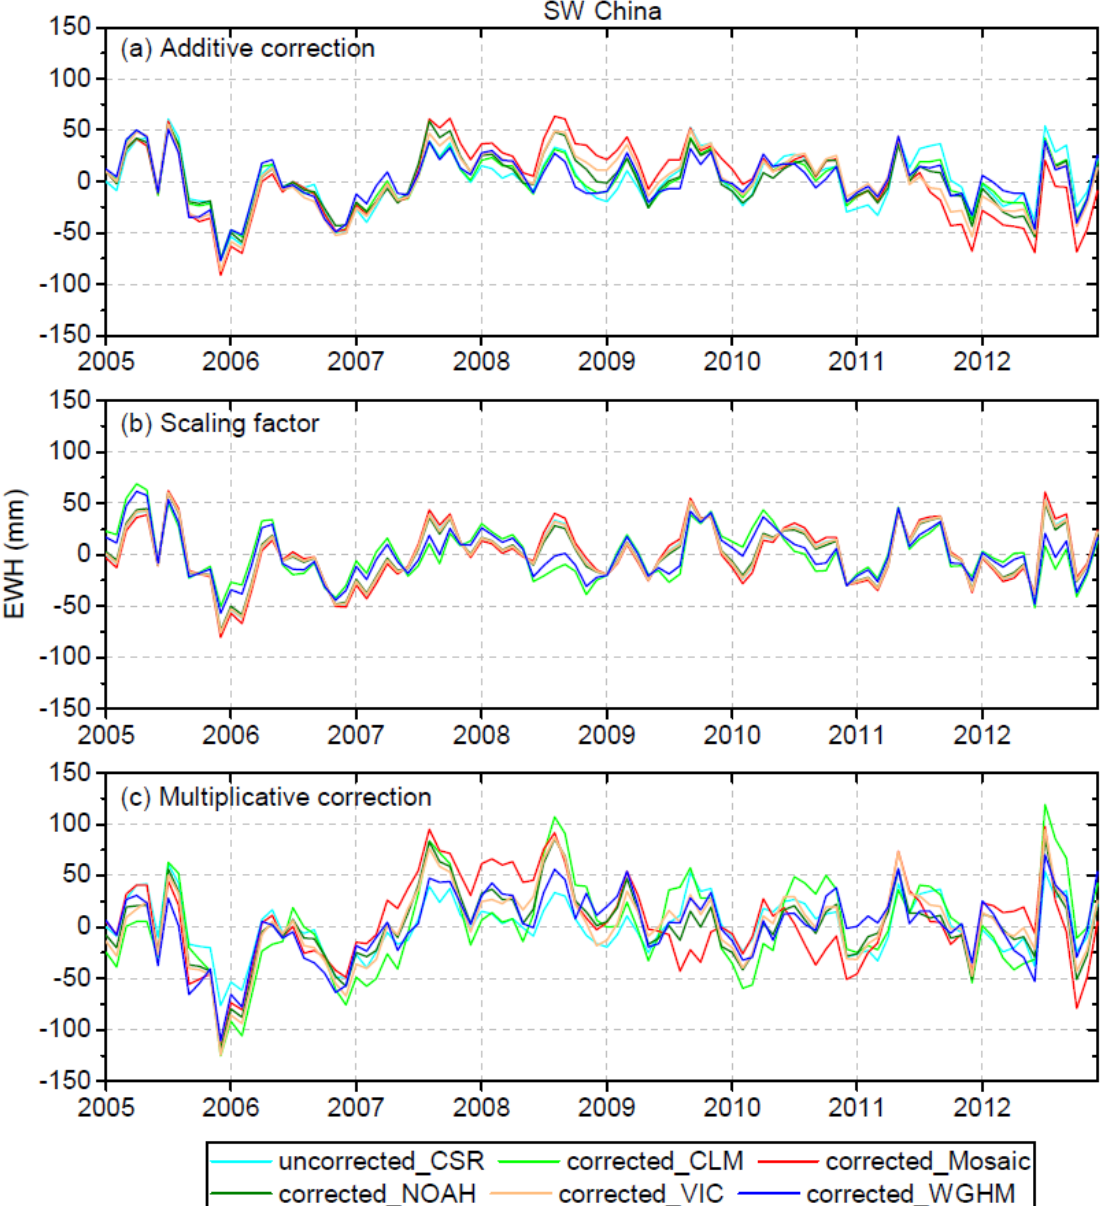
Figure 6. Residuals between uncorrected/leakage-corrected GRACE TWS and in situ observations of TWS for SW China. The leakage-corrected TWS is based on three different methods using the five model simulations as the a priori information.